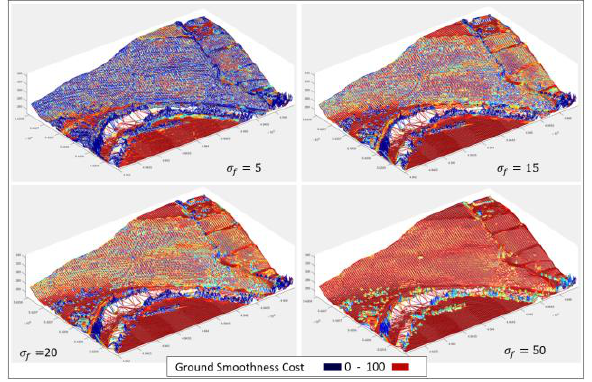
Figure 4. Ground smoothness cost change with respect to 𝜎 𝑓